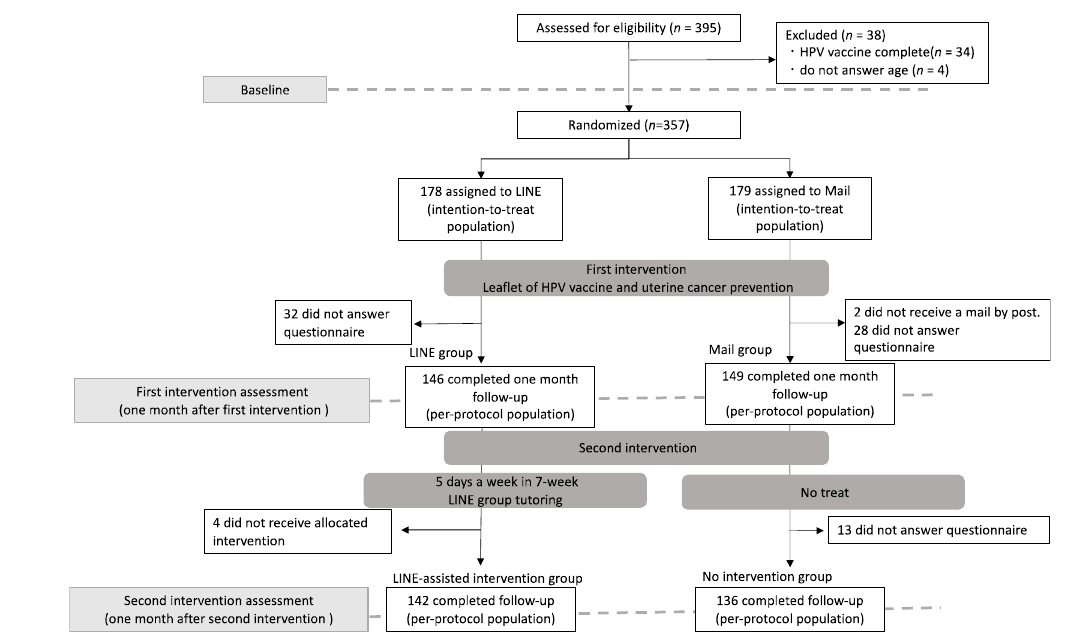
Figure 1. Flow diagram. Figure 1.